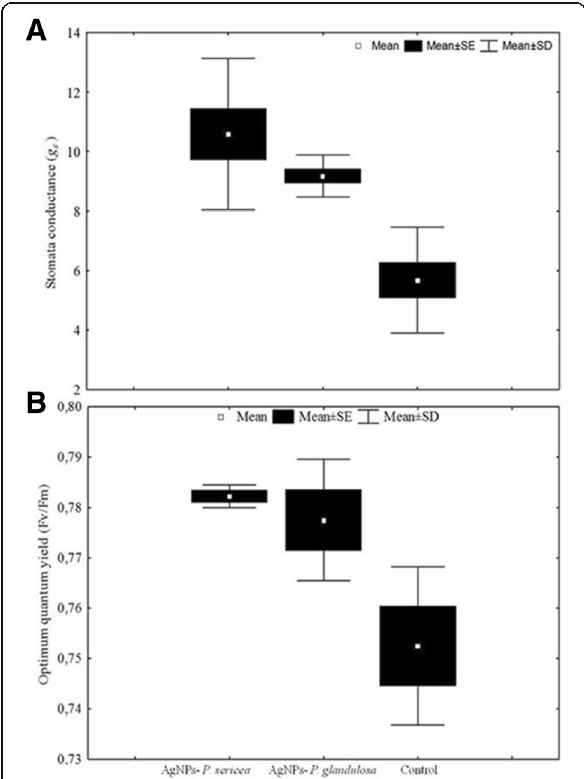
Fig. 4 a Effects of AgNPs from P. sericea and P. glandulosa in the number of lateral roots of cotton plants after 30 days of treatment. b Lateral roots of cotton plants after 30 days of exposition to AgNPs from P. sericea and P. glandulosa (values are expressed as mean ± S.D., n =